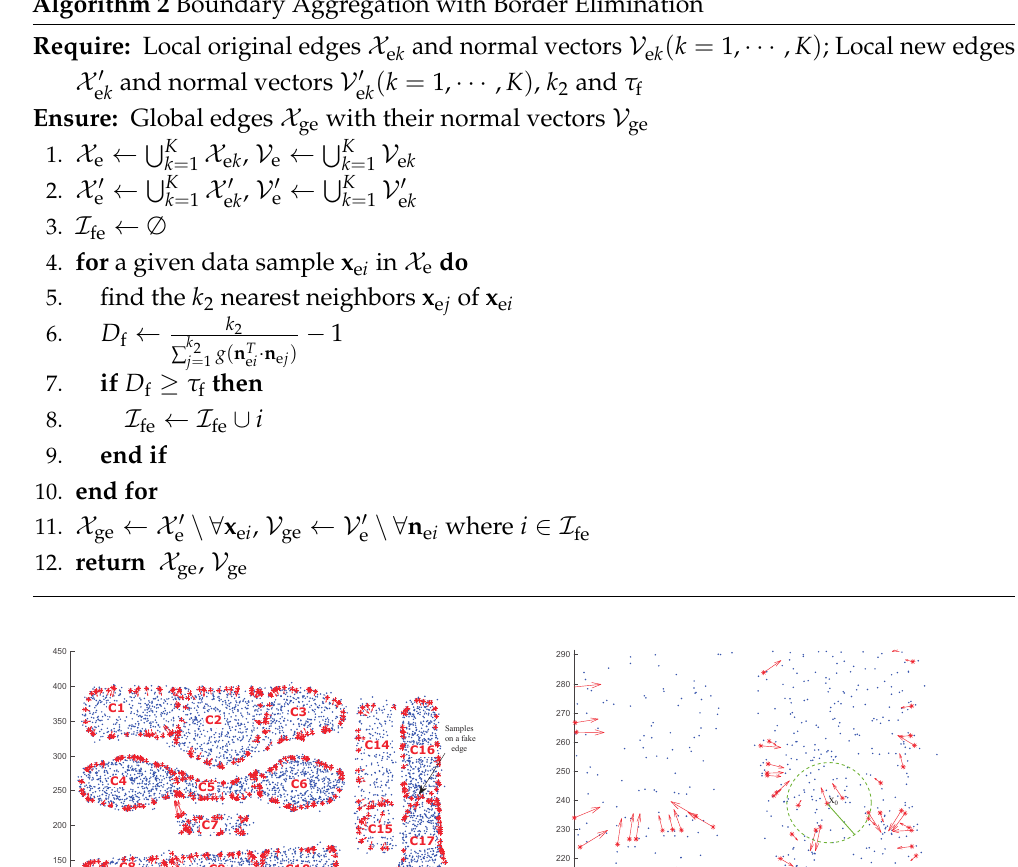
Algorithm 2 Boundary Aggregation with Border Elimination